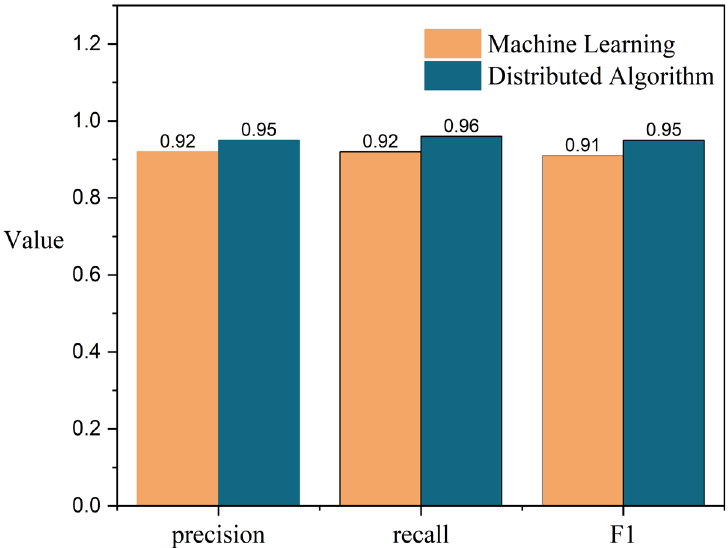
Figure 4. Model evaluation. Table 1. The results of treated online content